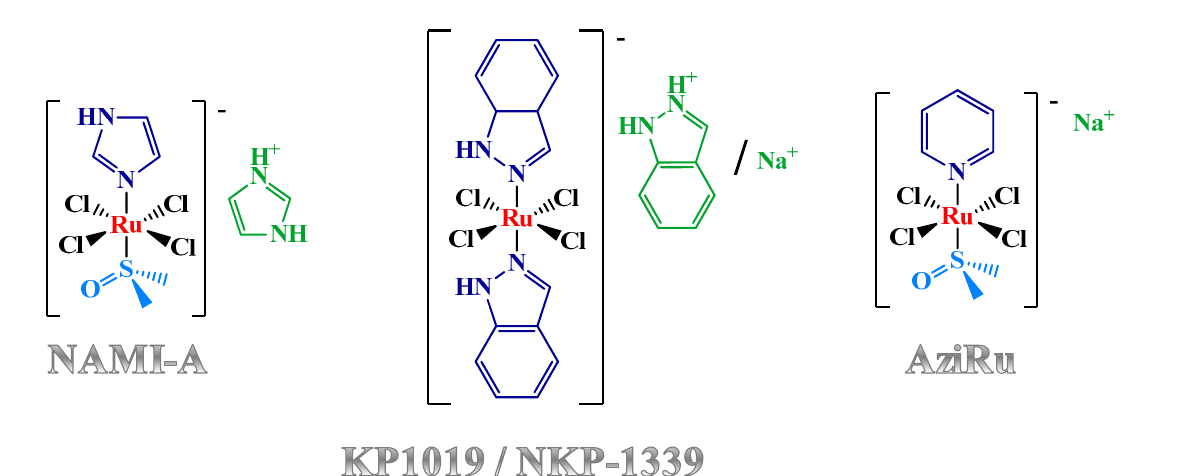
Figure 1. Chemical structures of NAMI-A, KP1019, NKP-1339 and AziRu. Here, ruthenium ions are indicated in red, the counterions in green, while the N- and S-donor ligands in dark and light blue, respectively.